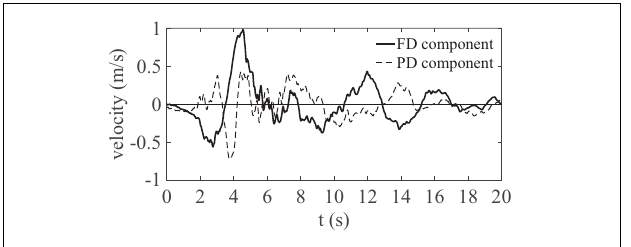
FIGURE 9 | The velocity time history of the FD and PD components of an NF record pair from the 1979 Imperial Valley event.